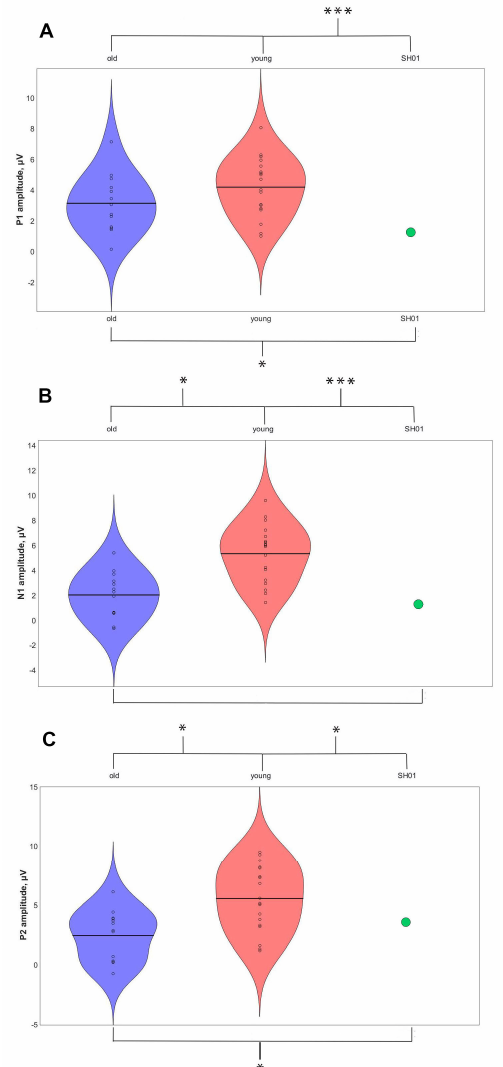
Figure 7. ERPs components across groups. P1 component is shown in ( a ), N1 is shown in ( b ), P2 is shown in ( c ). The old typically developing (TD) group’s values are shown in the first column, the young TD’s values are shown in a second, and SH01’s value is shown in the third (* shows significant differences p < 0.05, *** shows significant differences p <